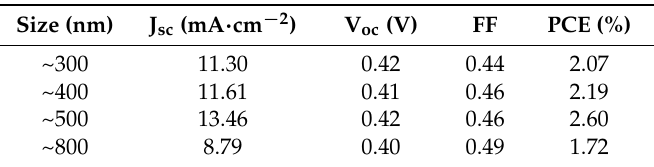
Figure 7. ( a ) Current density–voltage (J–V) curves of quantum dot sensitized solar cells (QDSSCs) based on Zn x Cd 1-x Se@ZnO HS with a size of 300, 400, 500, and 800 nm; ( b – e ) the corresponding TEM images of Zn x Cd 1-x Se@ZnO HS in different sizes with their power conversion efficiency (PCE). Table 1. Size influence of Zn x Cd 1-x Se@ZnO hollow spheres (HS) on photovoltaic performance. FF—fill factor; PCE—power conversion efficiency.